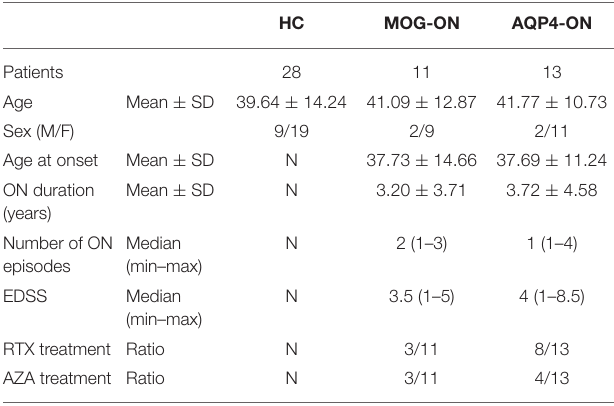
TABLE 1 | Demographic data of HCs and patients. HC MOG-ON